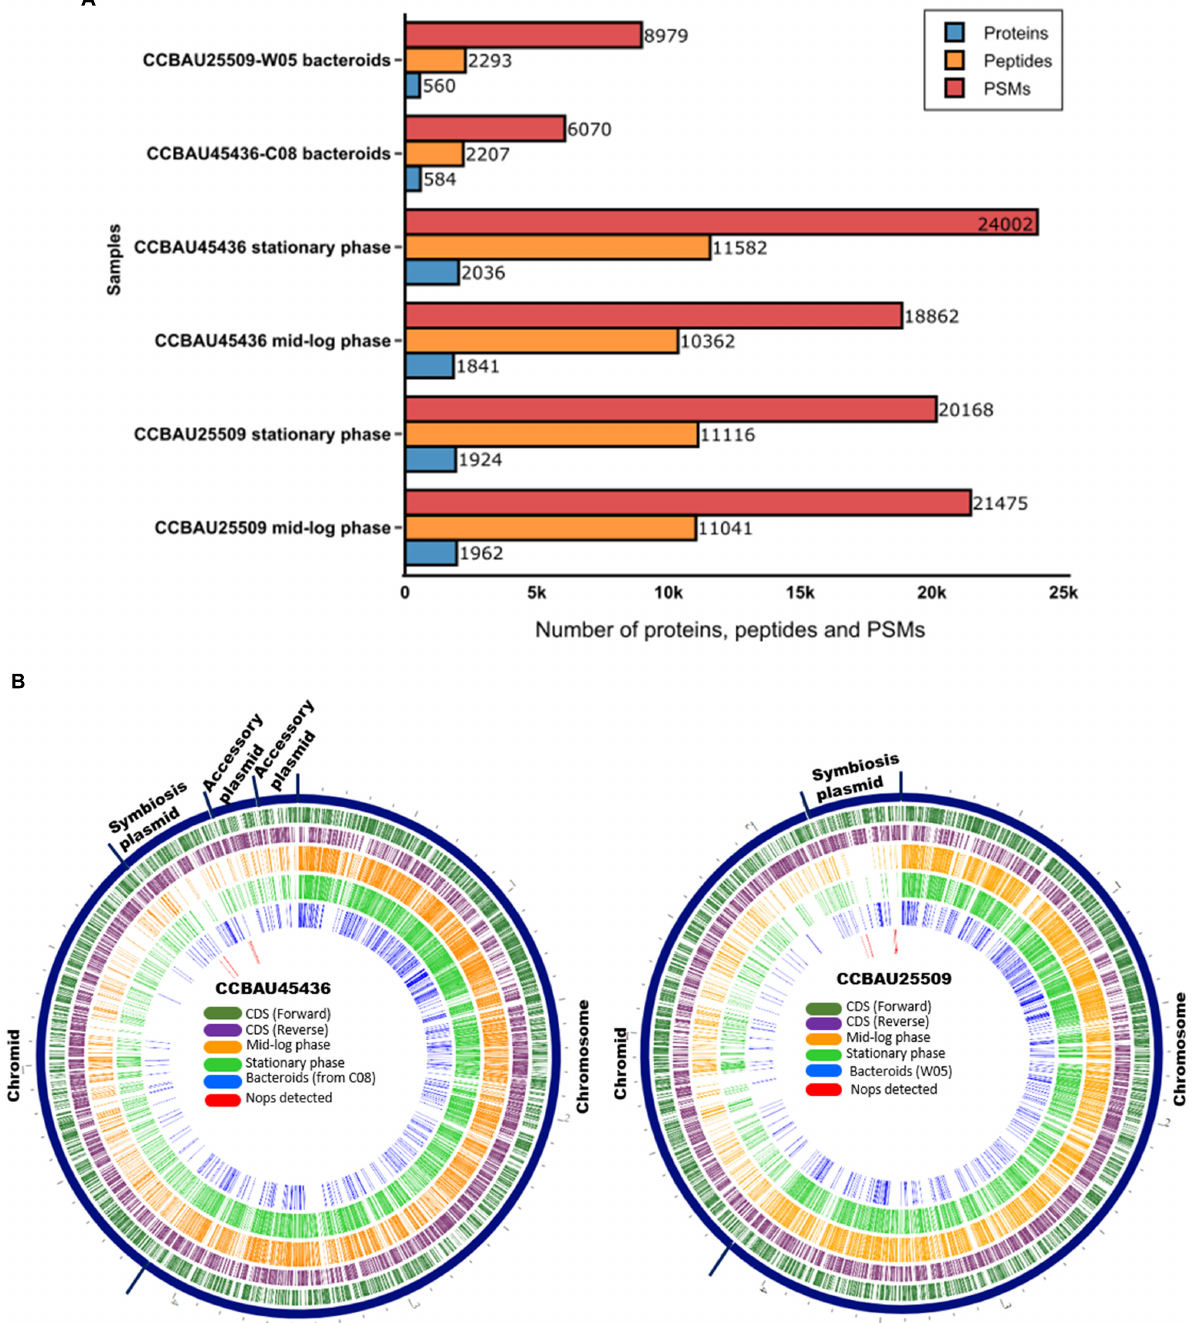
replicate with the false discovery rate (FDR) of q < 0.01 (Fisher’s exact test) ( Figure 1A and Supplementary Tables S3 , S4 ). Almost 600 proteins were detected from bacteroids collected from